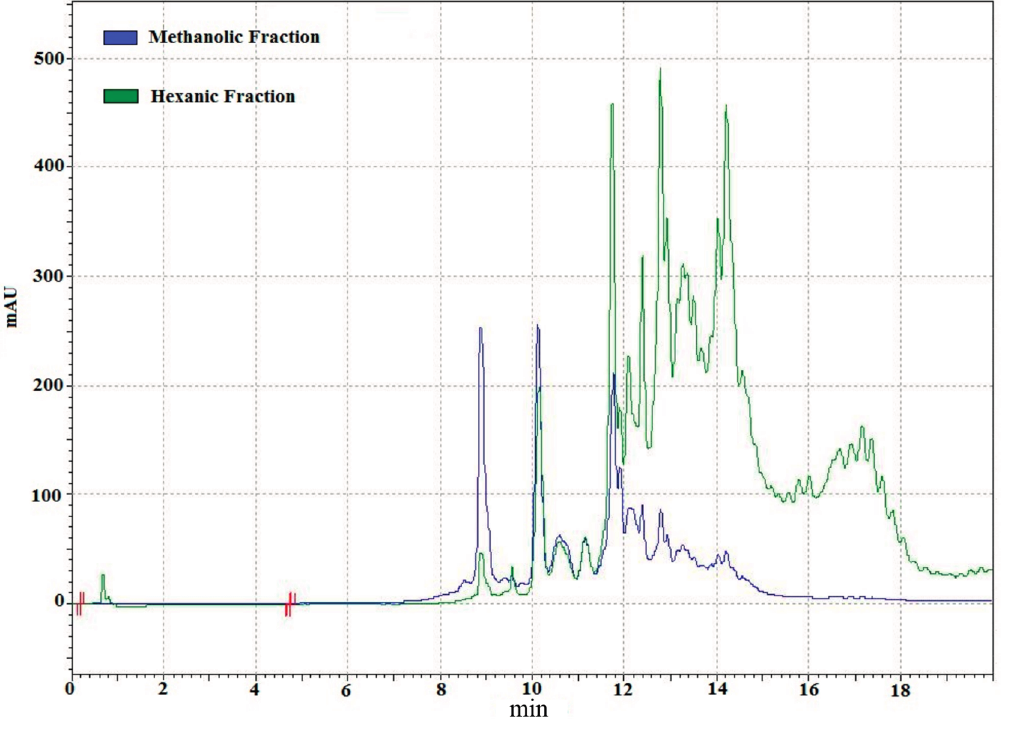
Figure 2. Chromatogram (450 nm) of methanolic and hexanic fractions obtained from lipidic extracts from